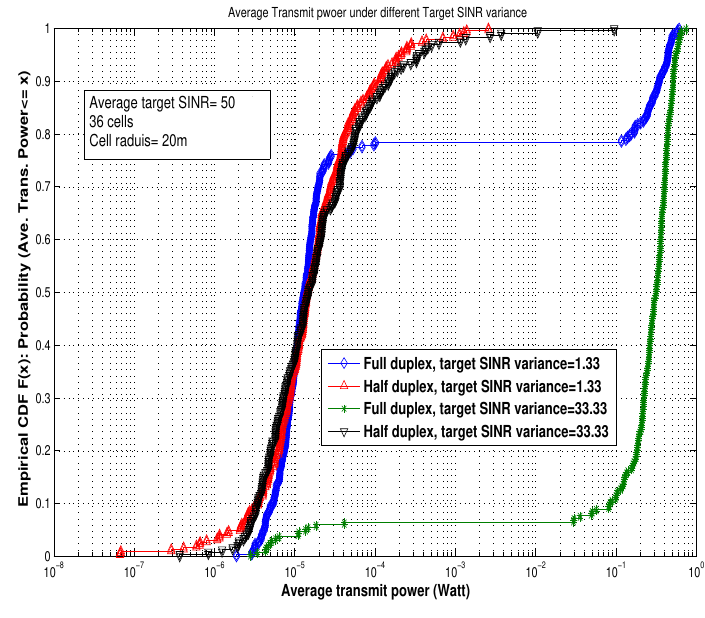
Figure 8. The CDF of the average transmit power under different target SINR